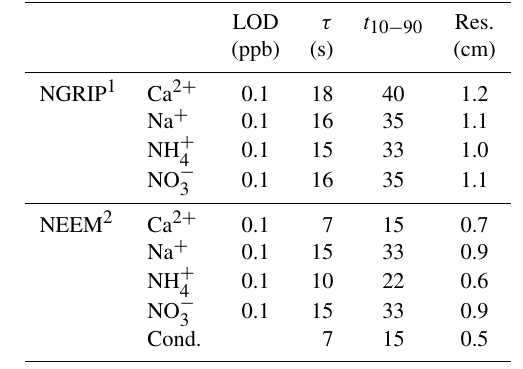
Table 1. Limits of detection (LOD), temporal resolution of the de- and resulting depth resolution (Res.) based on τ at the melt speeds used to generate the respective datasets. Note that the resolution does not account for additional signal dispersion during the melting and by the debubbling volume and is only a lower